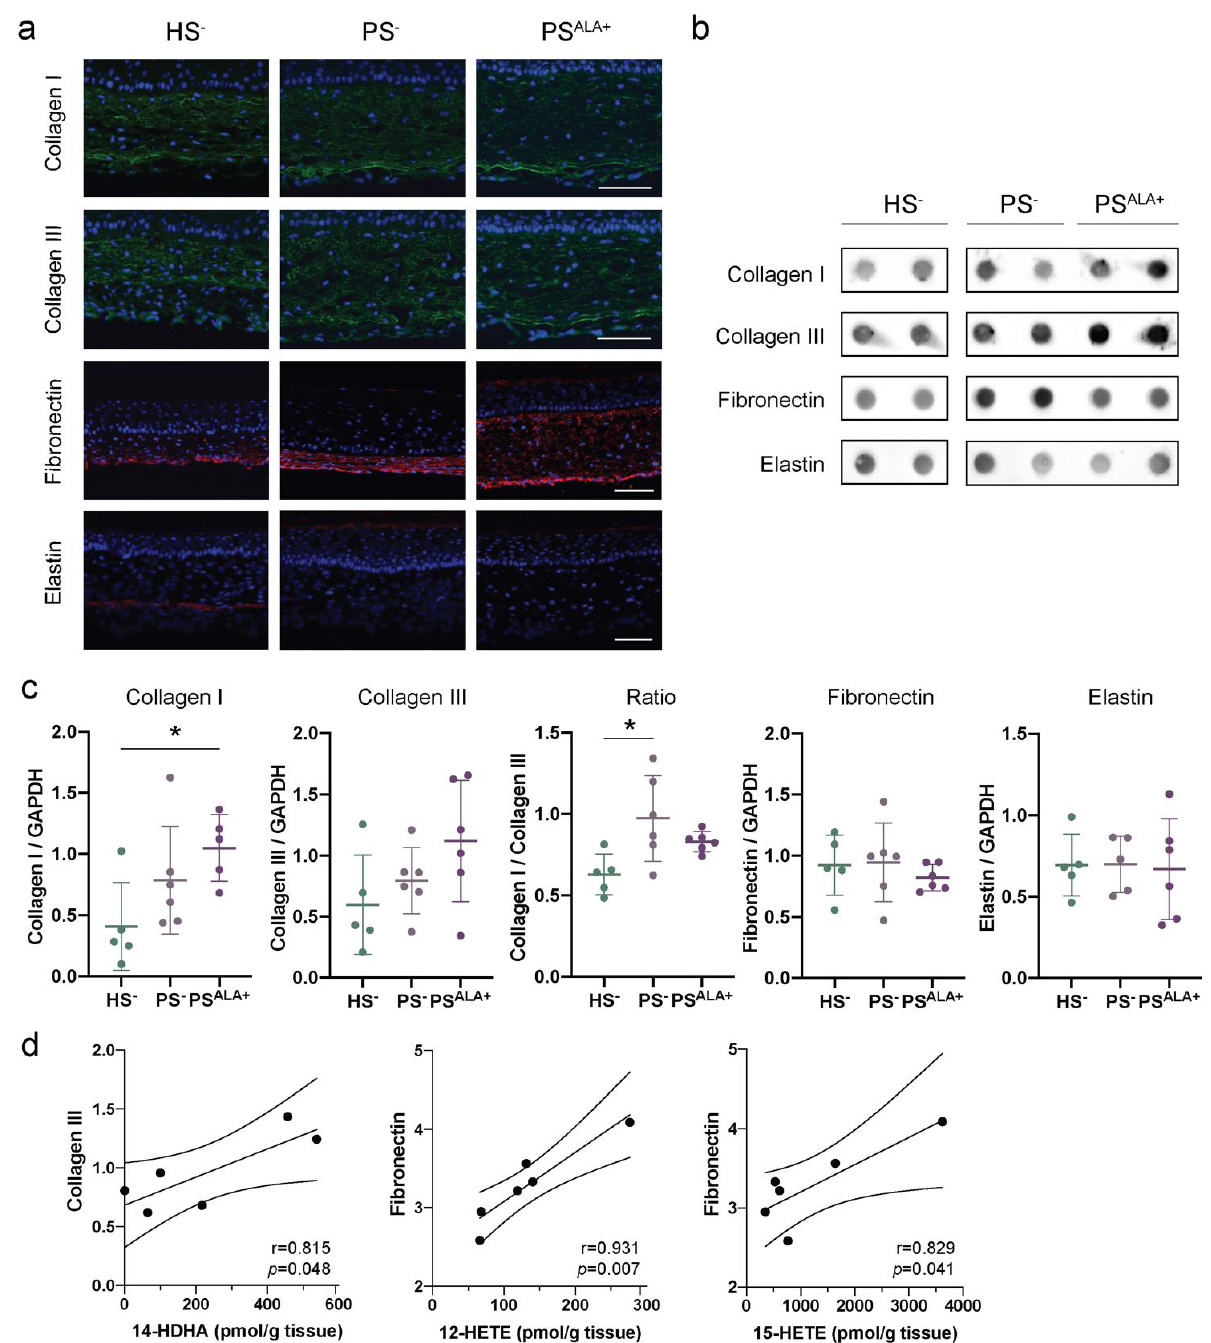
Figure 3. Impact of α -linolenic acid (ALA) on the levels of components of the dermal extracellular matrix in healthy and psoriatic skin substitutes. ( a ) Indirect immunofluorescence staining of collagen I (green), collagen III (green), fibronectin (red), and elastin (red). Nuclei were stained with DAPI (blue). Scale bar: 100 µ m. ( b ) Dot blot analysis of collagen I, collagen III, fibronectin, and elastin. ( c ) Densitometric analysis of the dot blot from panel b. Statistical significance was determined using one- way ANOVA followed by Tukey’s post -hoc test. * p < 0.05. ( d ) Linear regression analyses assessing the correlation of ECM proteins to specific lipid mediators. The correlation coefficient was determined according to Pearson’s correlation coefficient (r), and the significance according to two -tailed test p -value ( p ). Values are means ± SD (N = 3 donors, n = 2 skin substitutes per donor). Ab-